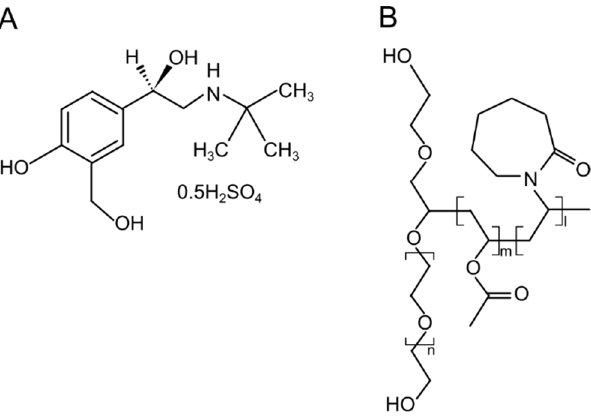
Figure 1. The molecular structures of ( A ) salbutamol sulfate and ( B ) soluplus.